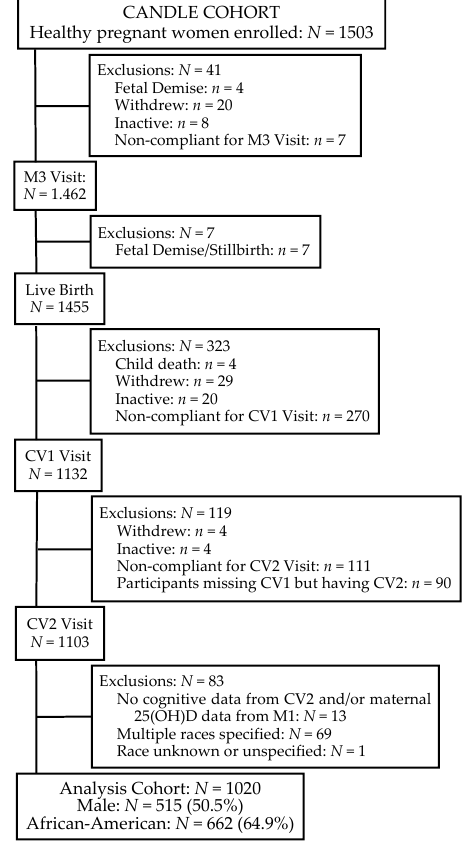
Figure 1. CANDLE participants available for study. M3, maternal visit 3; CV1, child visit 1; CV2, child visit 2.